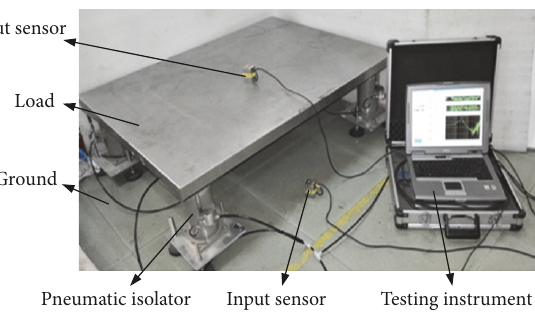
Figure 11: Total stiffness of the elastomeric diaphragm.